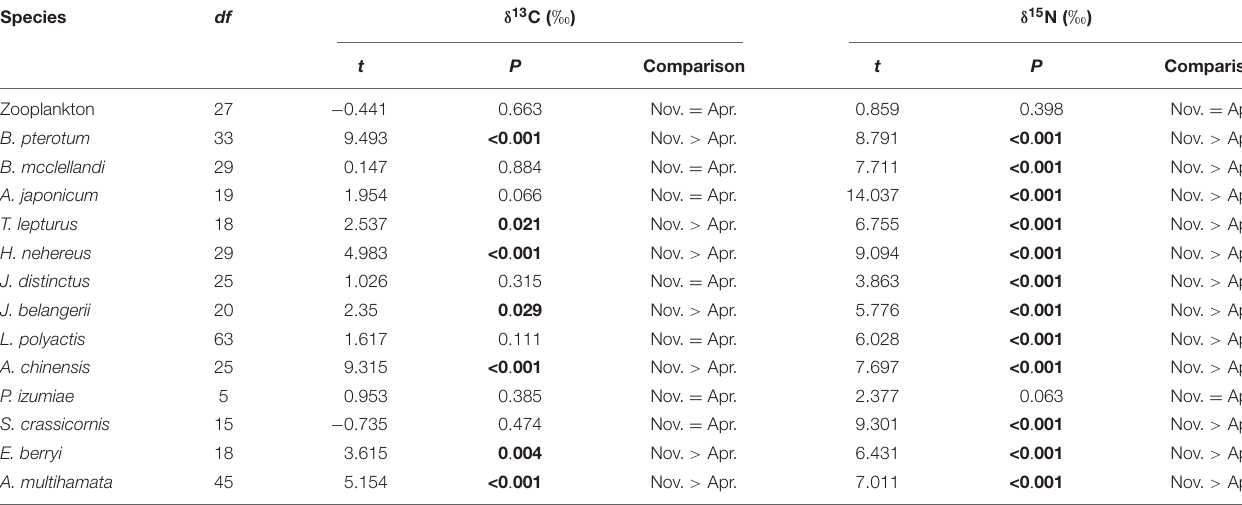
Bold values indicate significant differences (P < 0.05). TABLE 3 | Stable isotopic signatures of Bombay duck in different size groups during both sampling periods. Season Group Size classes